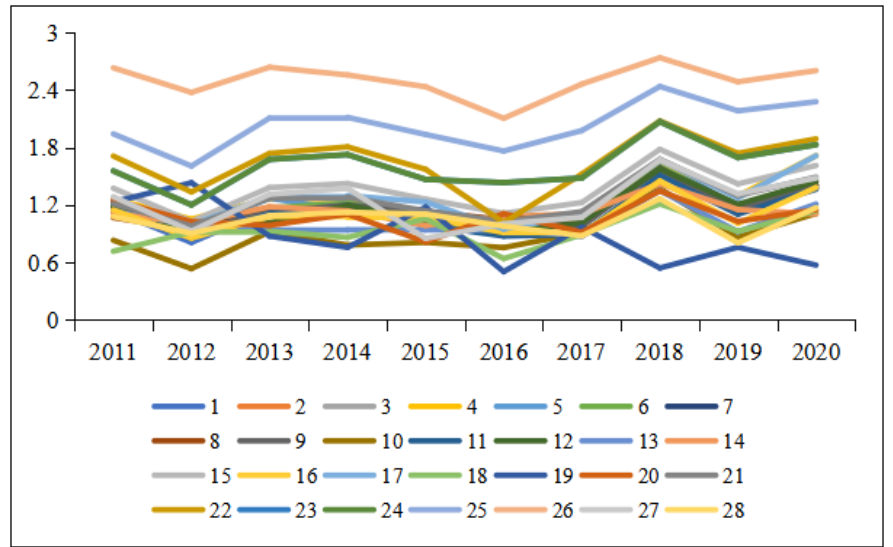
Figure 2. Best projection values of eco-innovation performance of China’s manufacturing industry by industry.